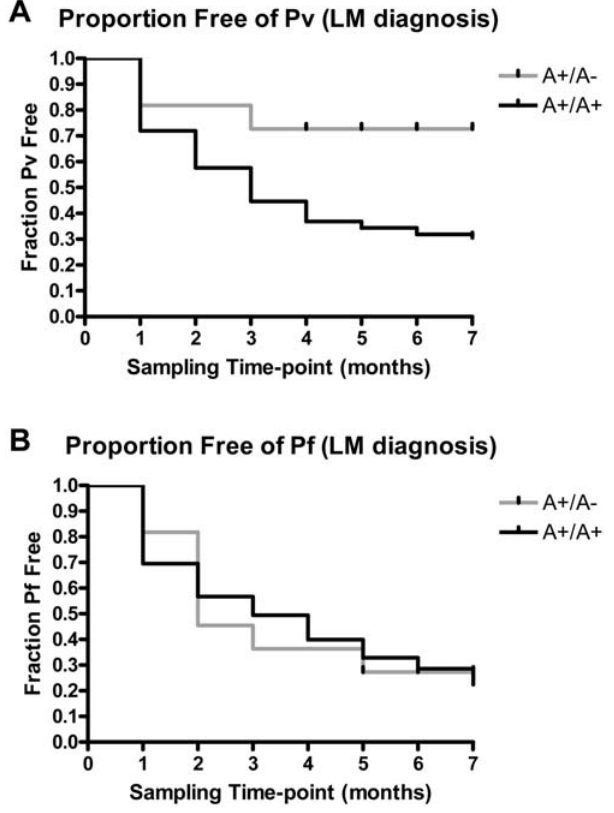
Figure 1. Susceptibility to blood-stage infection during monthly prevalence surveys (1998–99); unmatched longitudinal analyses. Diagnosis of Pv and Pf erythrocyte infection was performed by light microscopy (LM) [16]. Light gray line represents A + /A 2 (n=11) and dark gray line represents A + /A + (n=453). A, Cumulative Pv erythrocyte infection in Duffy A + /A 2 vs A + /A + individuals in unmatched analyses ( p =0.026; log-rank test). B, Cumulative Pf erythrocyte infection in Duffy A + /A 2 vs A + /A + individuals in unmatched analyses ( p =0.875; log-rank test).